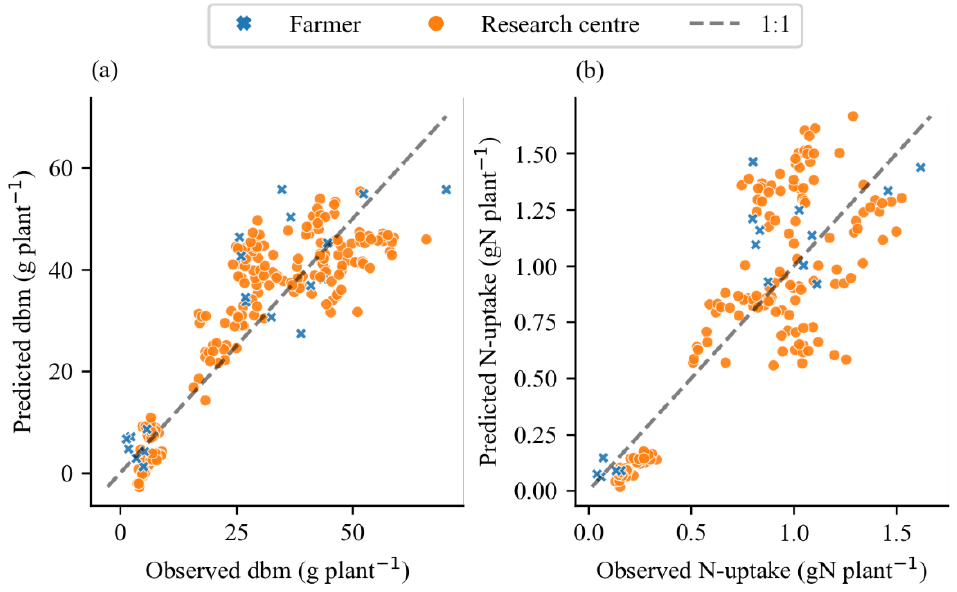
Figure 7. The predicted dbm ( a ) and N-uptake ( b ) in function of their observed values at the research centres (orange dots) and farmer fields (blue crosses) from the experiments in 2020. Table 6. Summary of the prediction accuracy for leek DBM and N-uptake for leek varieties that were not included in the training